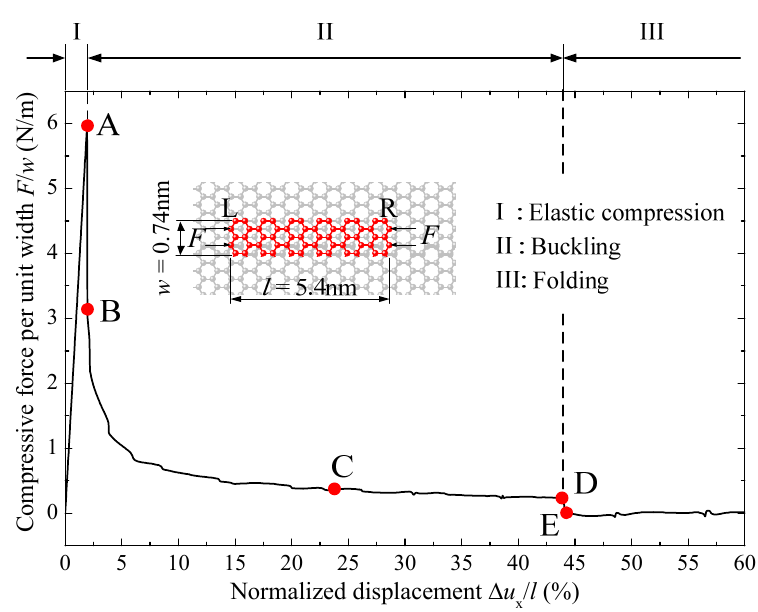
Figure 4. The compressive stress versus normalized displacement of the narrow monolayer graphene sheet supported by a graphene substrate.